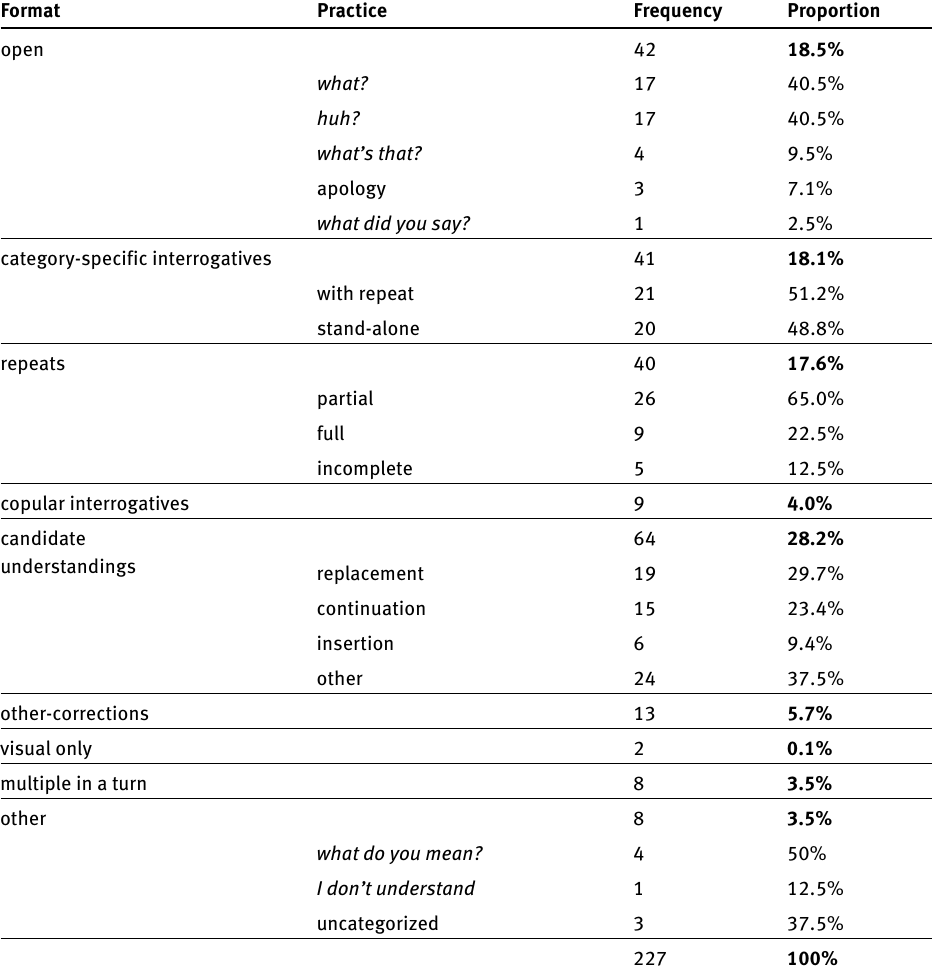
Table 1 The distribution of general formats and particular practices for other-initiation of repair in English. Proportions for formats occur in